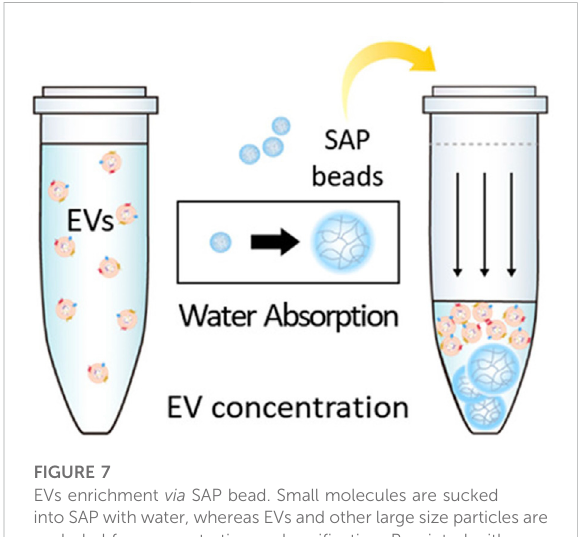
FIGURE 7 EVs enrichment via SAP bead. Small molecules are sucked into SAP with water, whereas EVs and other large size particles are excluded for concentration and puri fi cation. Reprinted with permission from Yang et al. (2021).